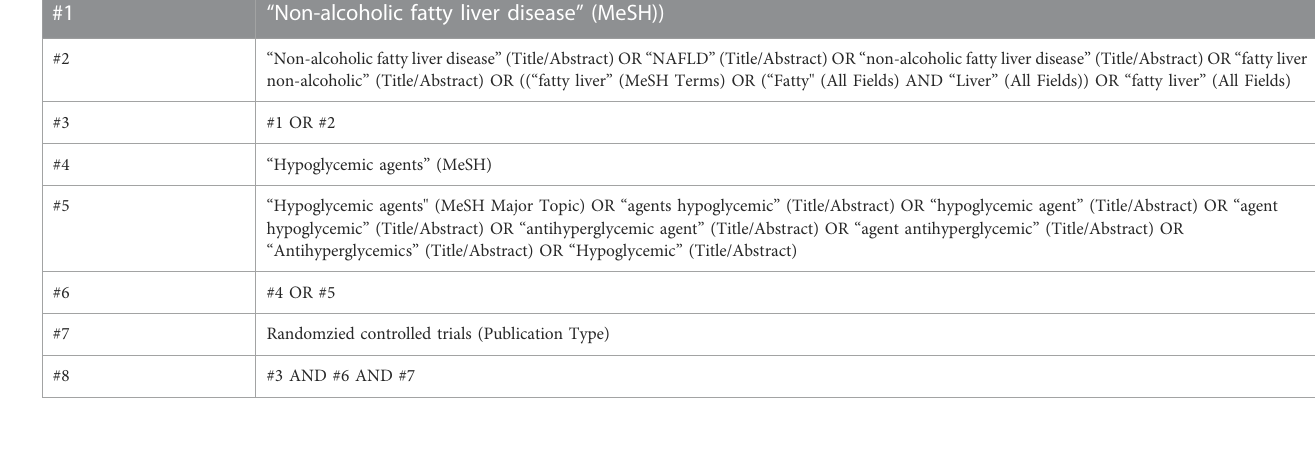
following headings: (Zou et al., 2018): author, (Okamura et al., 2021), year of publication, (Younossi et al., 2016), country, (Younossi et al., 2019), study period, (Paik et al., 2020), sample size, (Younossi et al., 2020), mean age, (Ge et al., 2020), intervention, and (Ito et al., 2021) reported endpoints of interest.